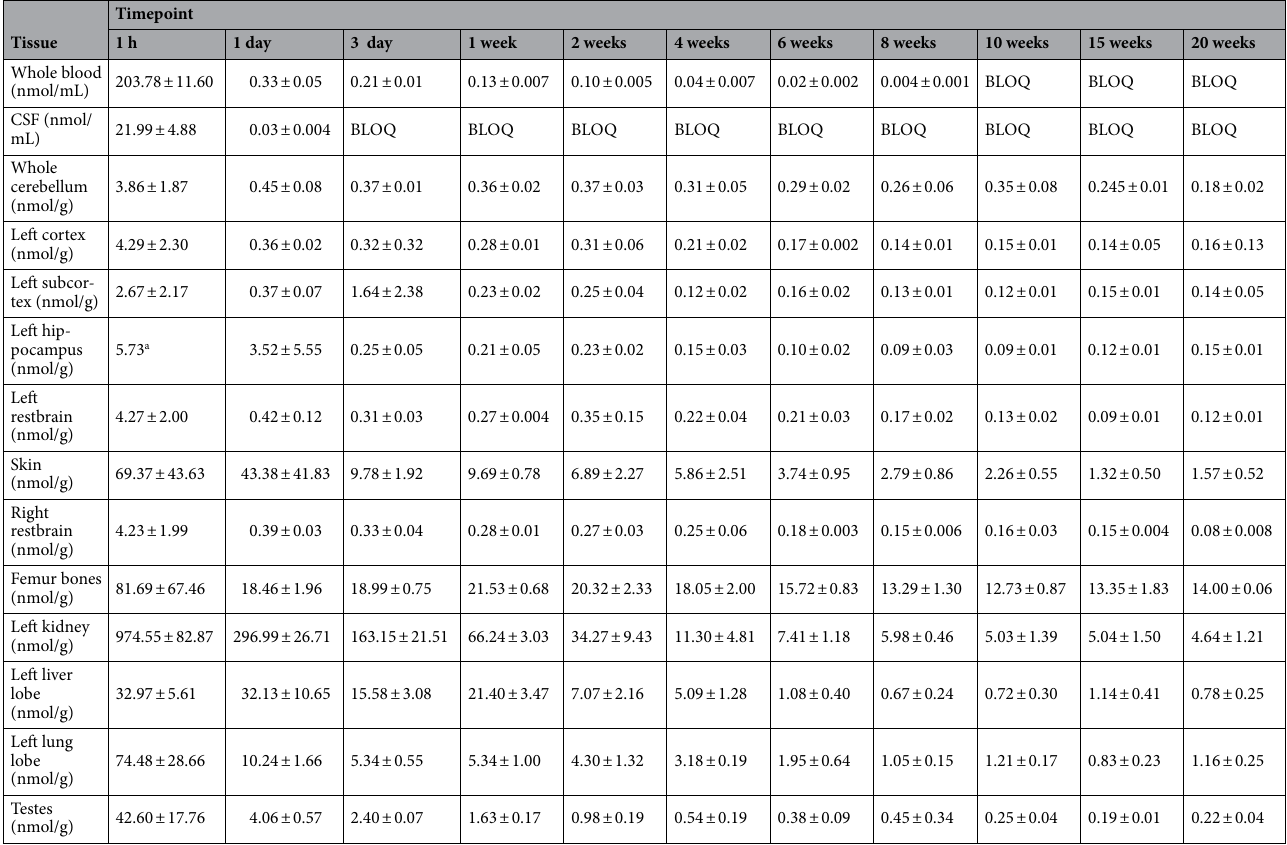
Table 2. Gadolinium concentrations as measured by ICP-MS after a single dose of gadodiamide (0.6 mmol/ kg) in blood, CSF and tissues (n = 3 per group), ± S.D. a Denotes n =